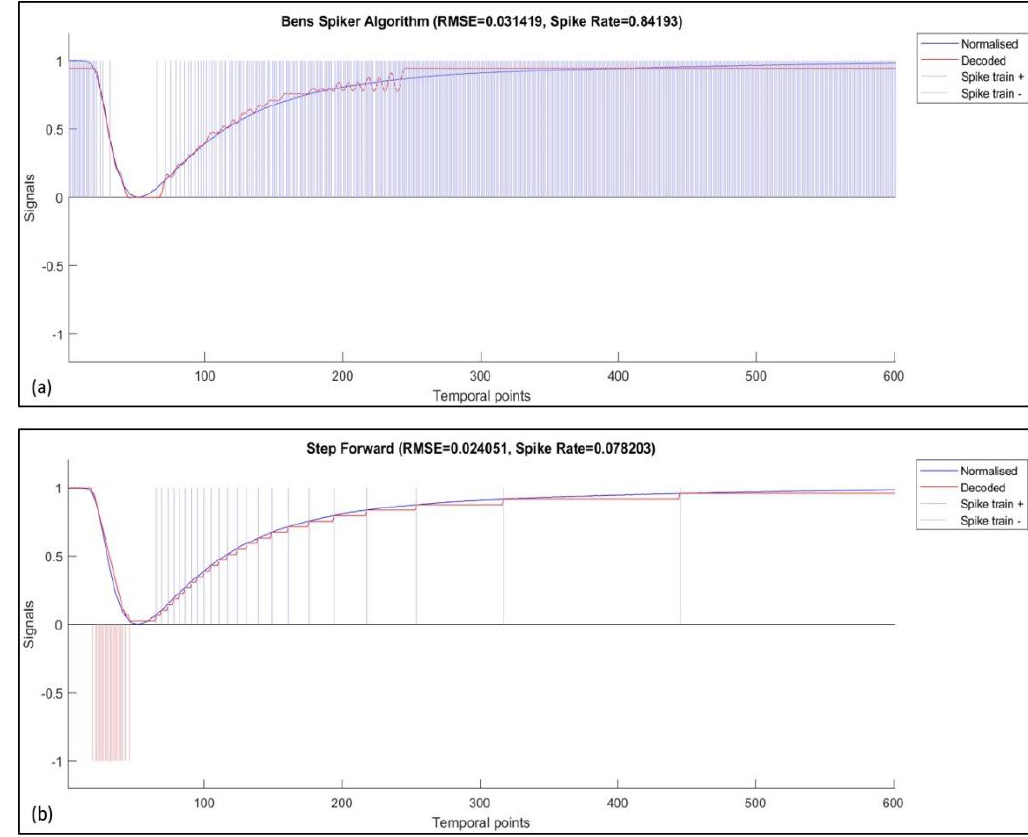
Figure 3. Spike-encoded data for sensor ten responses when exposed to 2-Butanone. ( a ) BSA encoding, ( b ) SF encoding.